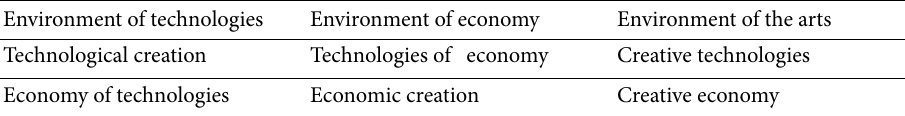
Table 1. Possible combinations and environments of the terms “technology”, “creation”, and